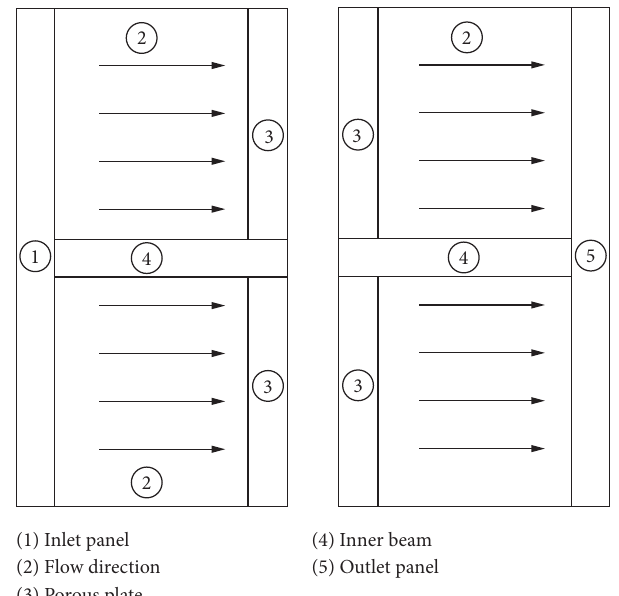
Figure 4: Schematic diagram for the water collecting